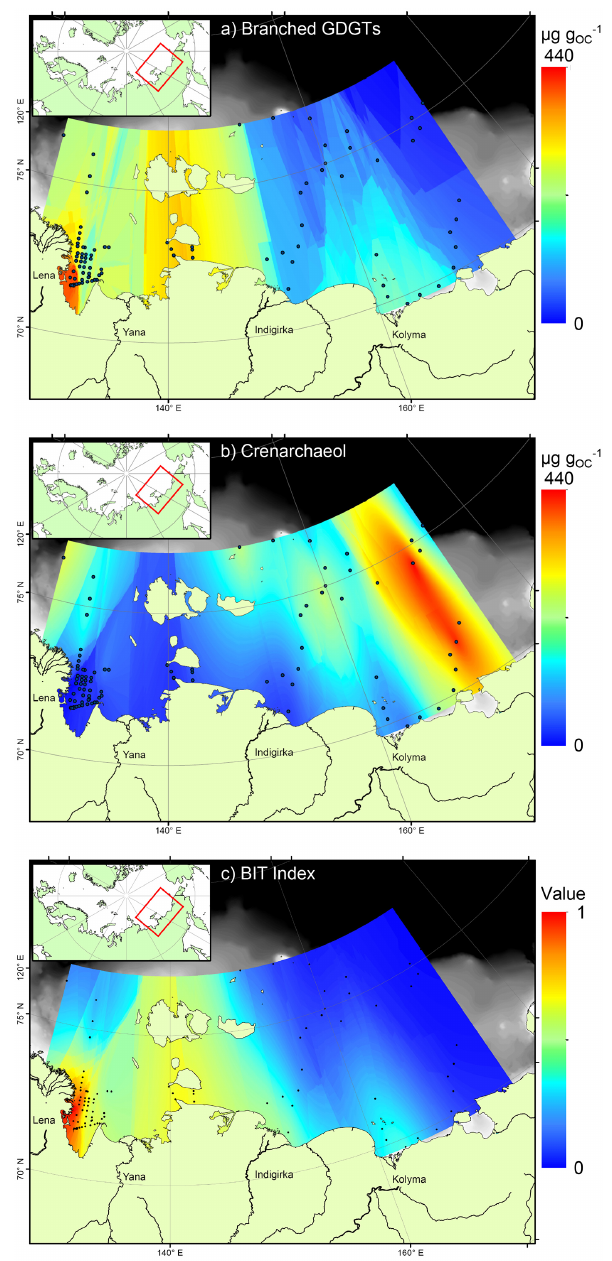
Figure 2. Maps of (a) summed brGDGTs and (b) crenarchaeol con- centrations, and (c) the BIT index on the ESAS. Maps were inter- polated using a kriging algorithm, and the locations of ISSS-08 sta- tions are shown with black